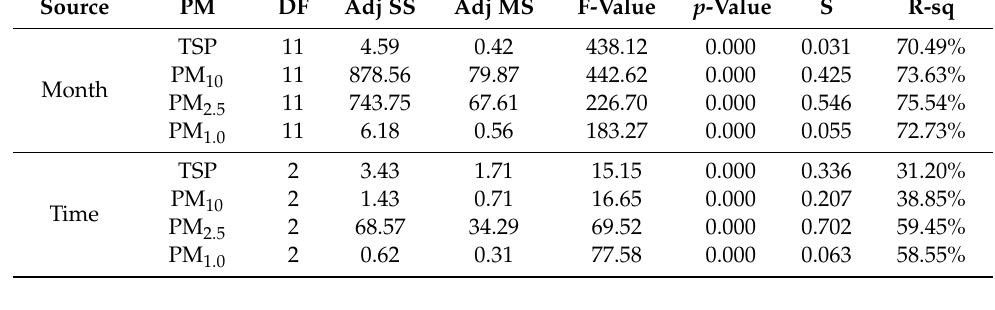
Table 3. General linear analysis of month, time and atmospheric suspended particulate matter concentration.